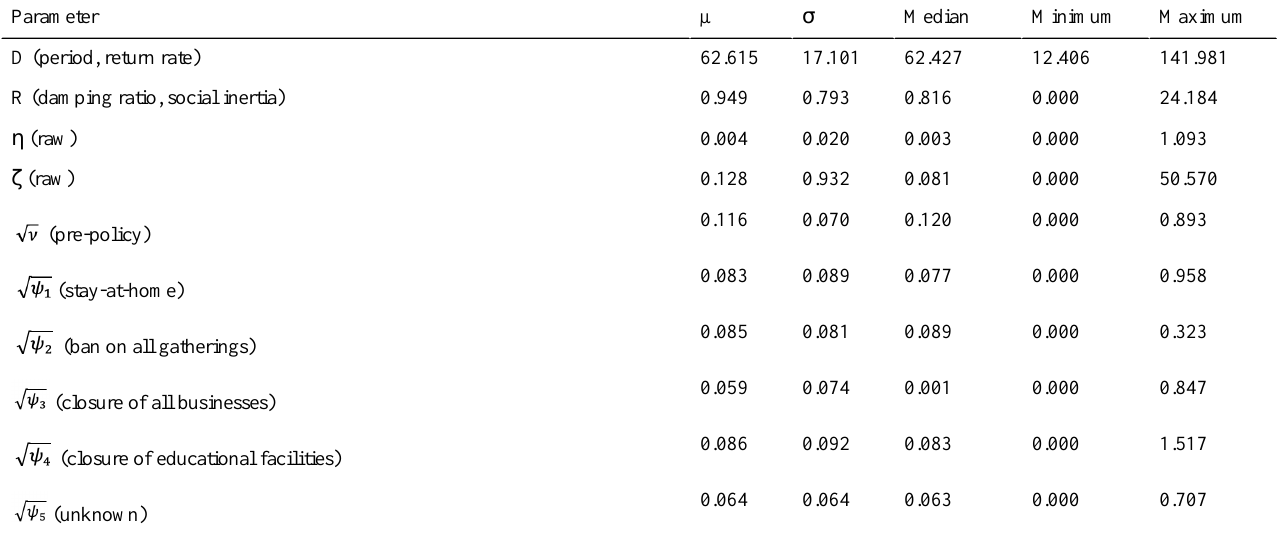
Table 3. Descriptive statistics for all social distancing and policy